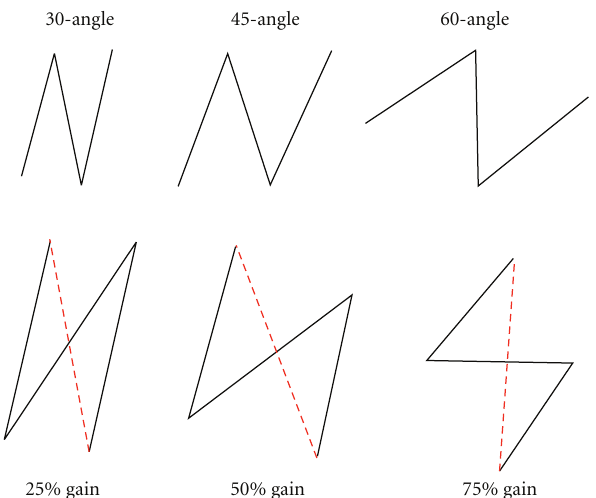
Figure 2: The degree of scar directional change and lengthening is a ff ected by the angles of the flap. In the 30-degree Z-plasty, the direction of the change is approximately 45 degrees from the initial position of the central limb and there is a 25% gain in scar length. With a 45-degree Z-plasty, the resultant limb lies in a more oblique position, approximately 60 degrees from the initial position and there is a 50% gain in scar length. A 60-degree Z-plasty will yield a 75% increase in scar length and a 90-degree change in scar direction (the broken line represents the original